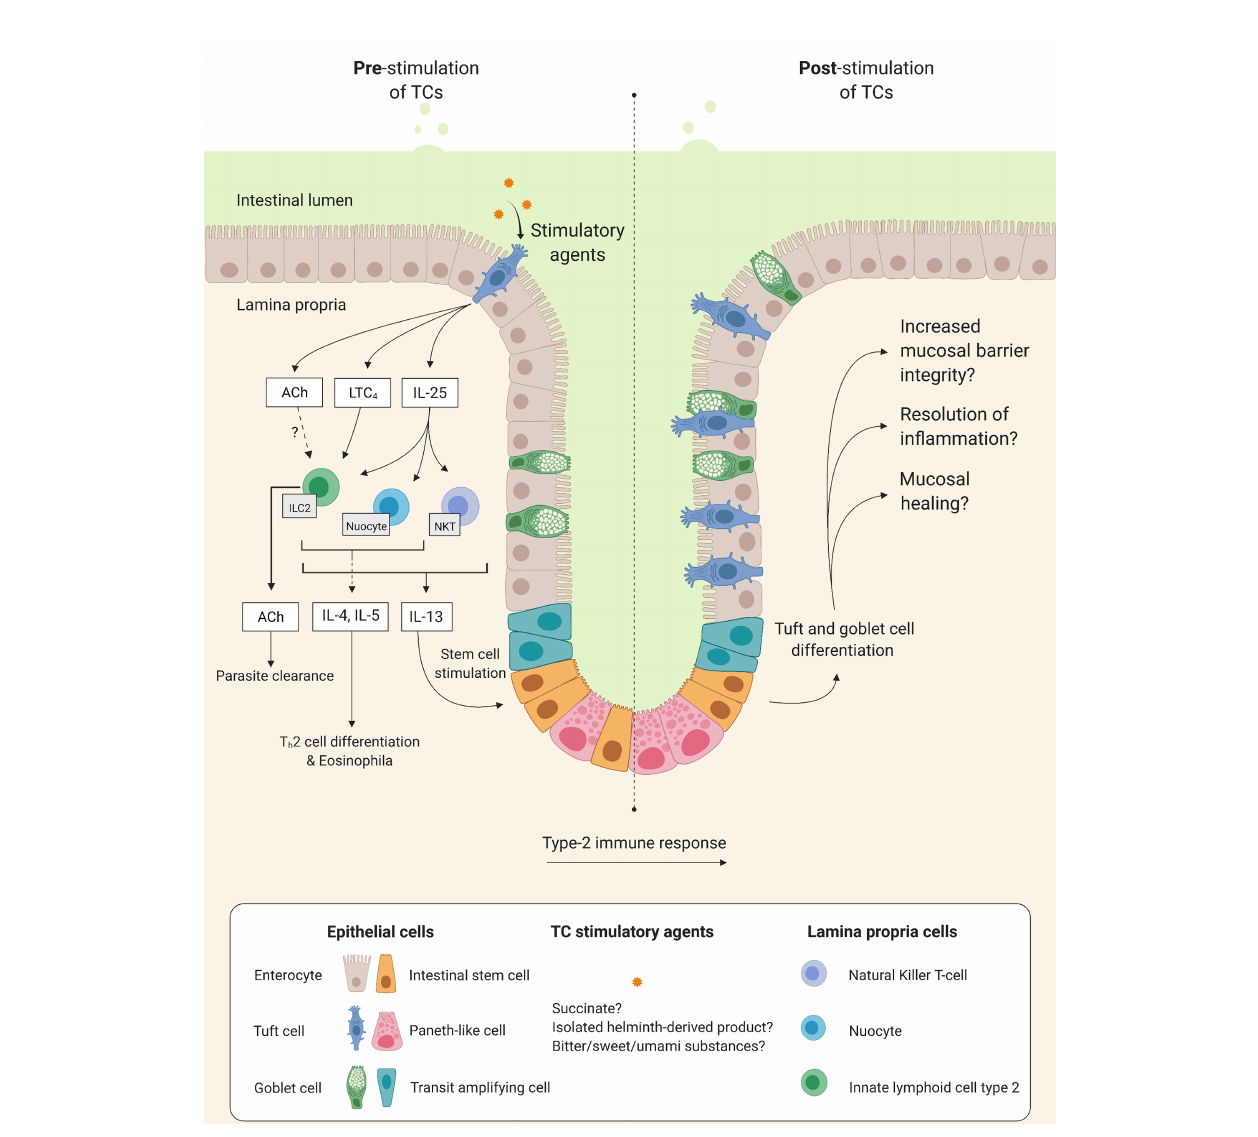
FIGURE 4 | Tuft cells (TC) as potential therapeutic targets. Illustration of hypothetical bene fi cial effects on mucosal integrity when stimulating TCs. Left and right side show intestinal mucosa before and after TC stimulation, respectively. Upon stimulation, TCs increase secretion of interleukin (IL)-25 and cysteinyl leukotriene C 4 (LTC 4 ) which in turn stimulate lamina propria immune cells such as, type 2 innate lymphoid cells (ILC2), natural killer T cells and nuocytes to produce and release type 2 in fl ammatory cytokines (e.g. IL-4, IL-5 and IL-13). This initiates differentiation of T helper type 2 cells (T h 2), recruitment of eosinophils and stimulation of intestinal stem cells leading to tuft cells and goblet cell differentiation and